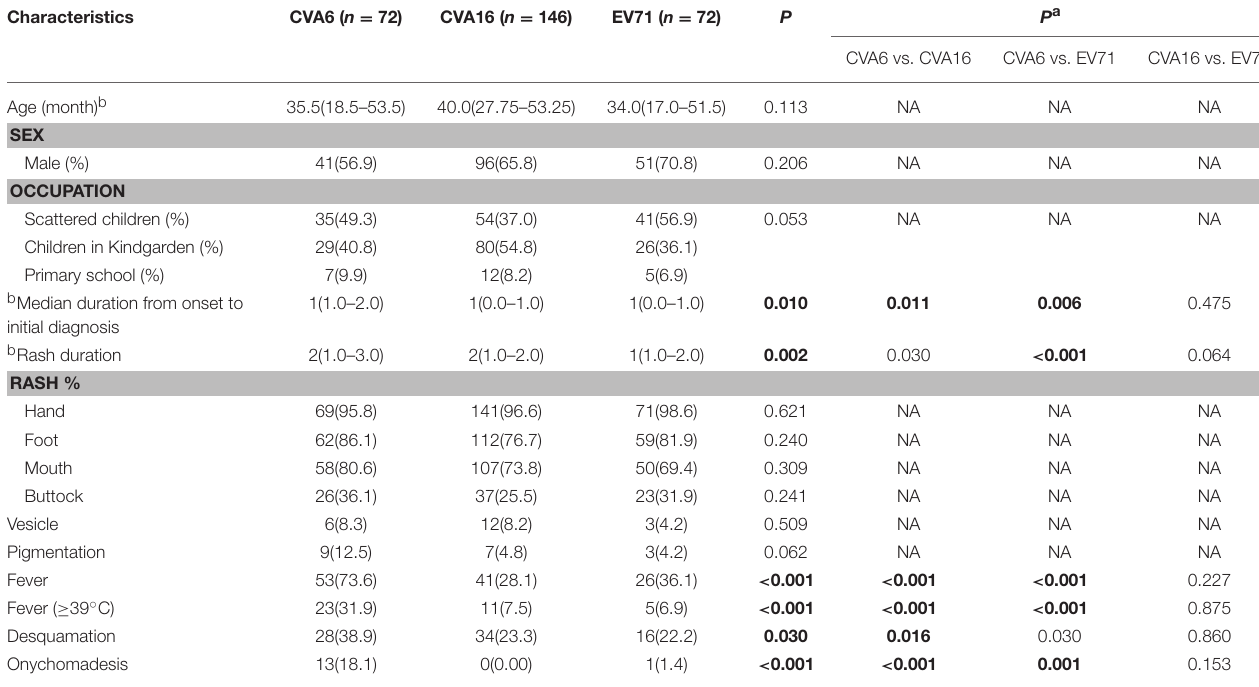
TABLE 3 | Epidemiology and clinical features of CVA6-, EV71,- and CVA16-associated mild cases in Beijing, 2013.